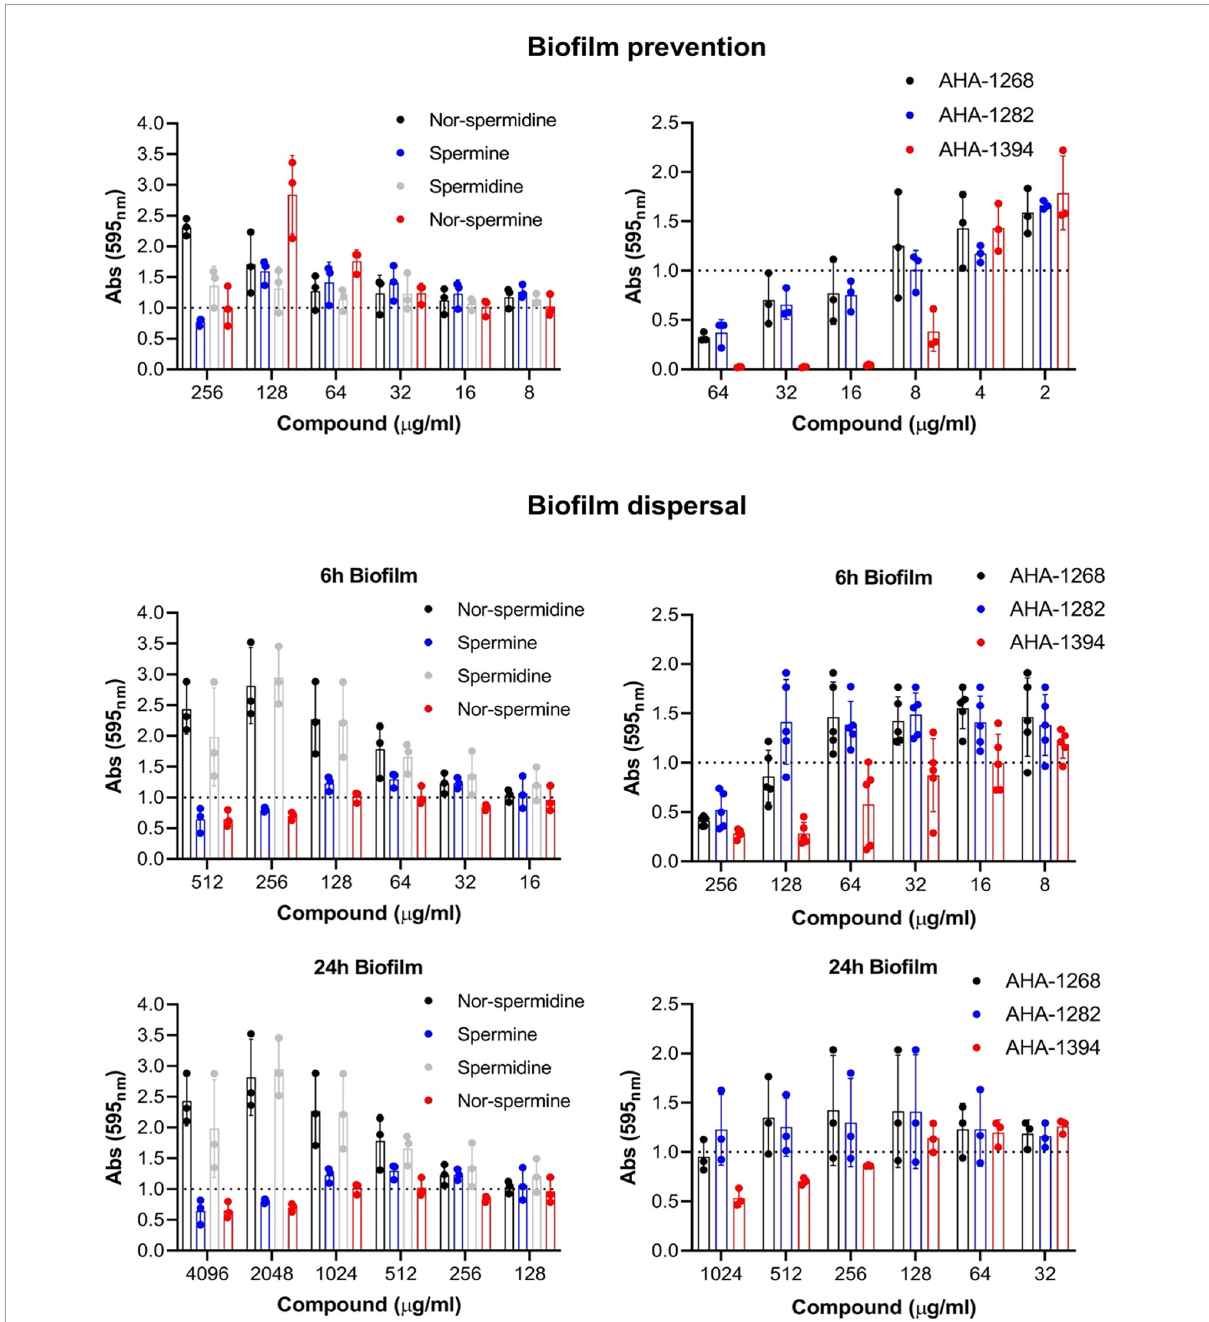
FIGURE2 AHA-1394 performs better than natural polyamines in biofilm inhibition. The biofilm prevention and dispersal activity of natural polyamines were compared to AHA-1268, AHA-1282 and AHA-1394. For biofilm prevention polyamines were added at a final concentration ranging 256–2 µ g/ml, whereas for biofilm dispersal polyamines were added at a final concentration ranging 4,096–8 µ g/ml. Absorbance 595 nm values of the polyamines below the normalized threshold of 1.0 showed biofilm preventative and dispersal activity. The dots represent biological replicates with the bars representing the mean and error bars the standard